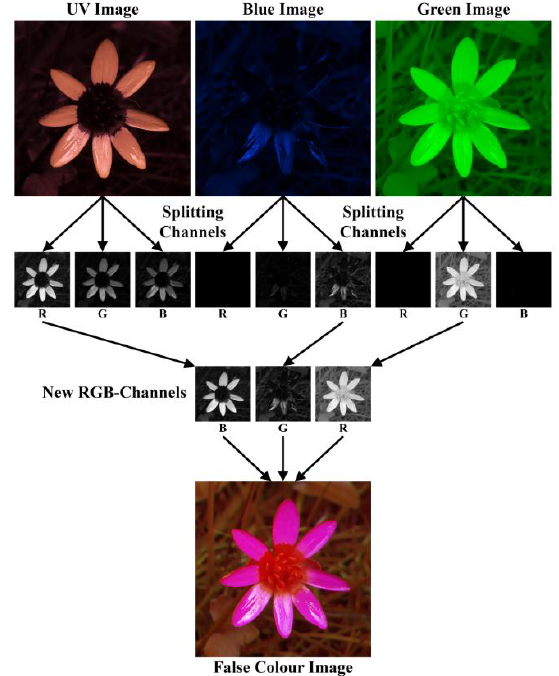
F IGURE 4. The splitting and merging process in